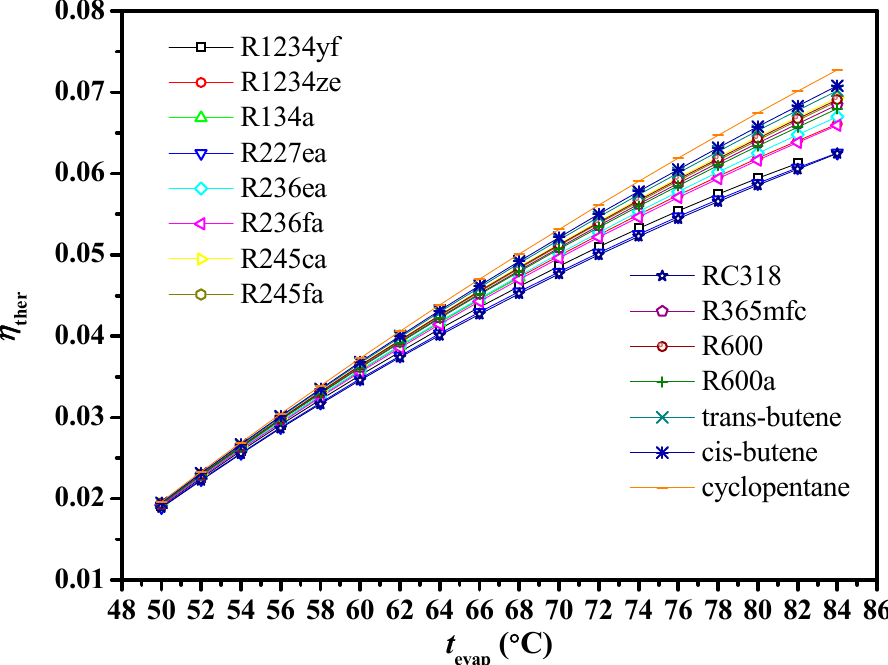
Figure 10. Variation of thermal efficiency with evaporating temperature.